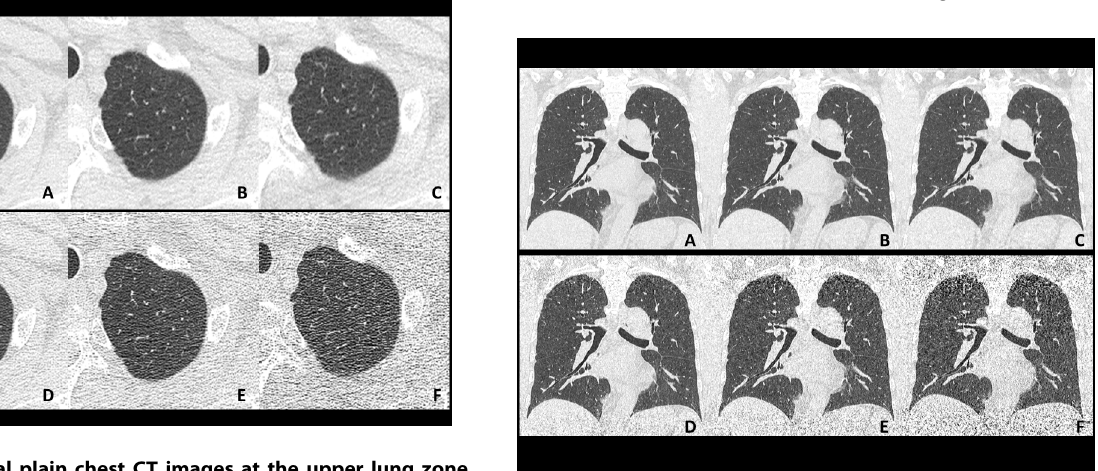
Figure 1. Axial plain chest CT images at the upper lung zone (60-year-old male weighing 76 kg). These images were created from scan data at 240 mA ( A, D ), 120 mA ( B, E ) and 60 mA ( C, F ). The three upper images ( A–C ) were reconstructed using AIDR3D and the three lower images ( D–F ) were reconstructed using a conventional reconstruction mode (Boost3D). Each image pair at the same tube current was created from single row data. Image noise was obviously reduced on images with AIDR3D, particularly at lower tube currents.